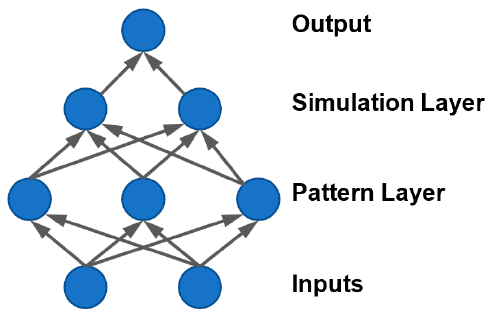
Figure 2. Example of Generalized Regression Neural Nets (GRN) net.